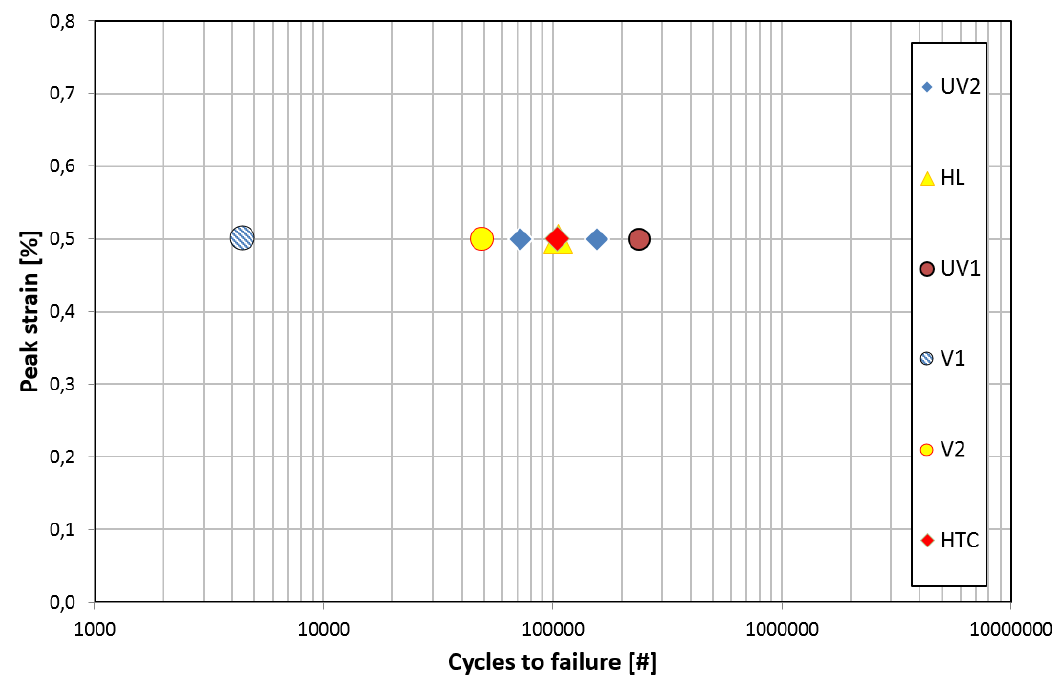
Figure 6. Cycle to failure for fatigue testing of peak strain 0.5%.